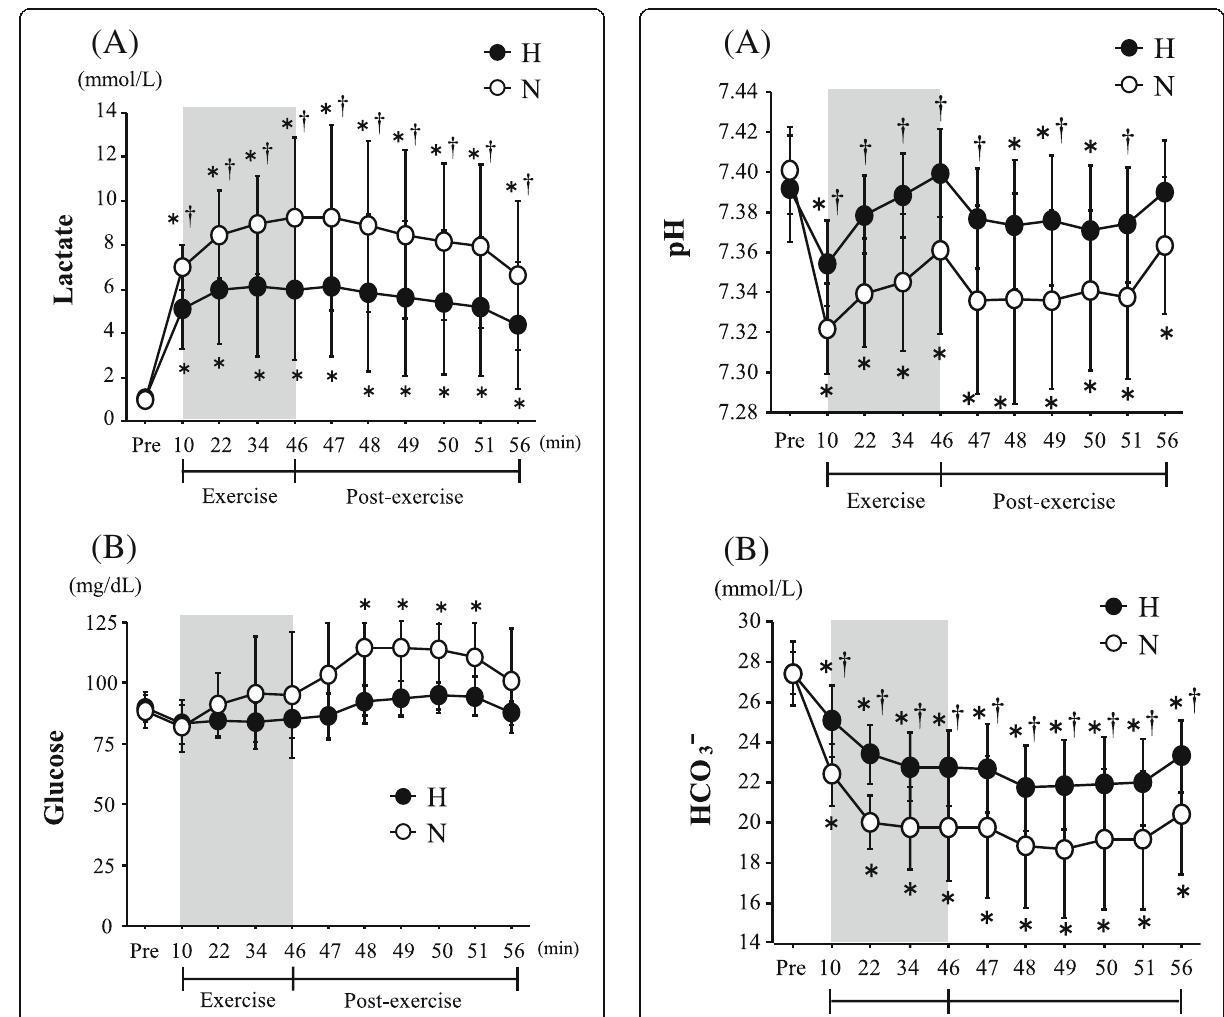
Fig. 2 Changes in blood lactate ( a ) and glucose ( b ) concentrations. Values are means ± standard error (SE). The shaded box indicates the duration of exercise. *Significant difference compared with pre-exercise (Pre). † Significant difference between the normoxic (N) and hypoxic (H) trials